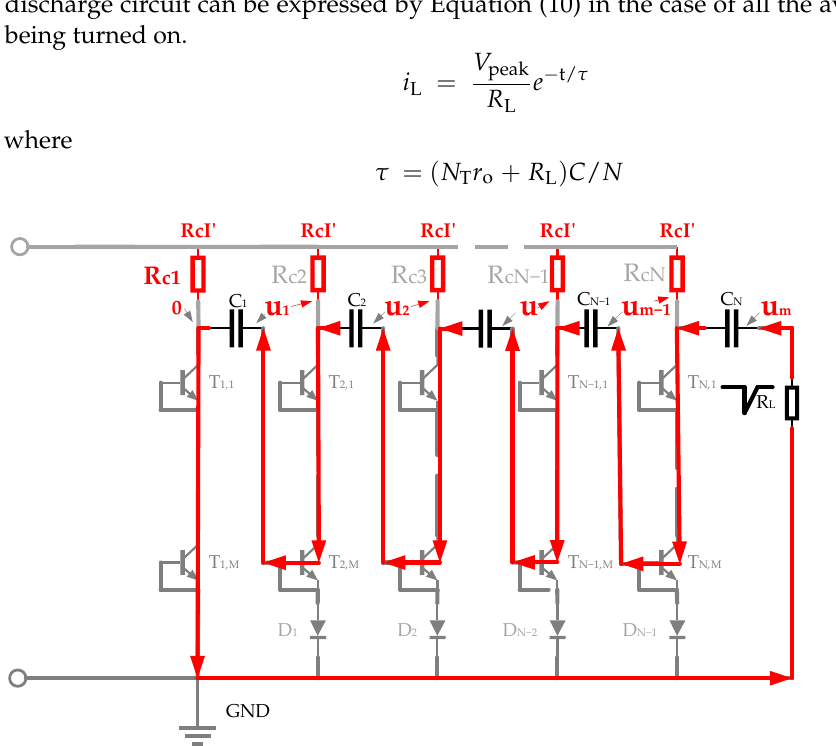
Figure 6. Schematic diagram of isolation resistance R c loss in the discharge period. V peak is the peak voltage of the output pulses, τ is the time constant of the discharge circuit expressed by Equation (11), and N T is the number of avalanche u 1 ~ u m are shown in Figure 6.